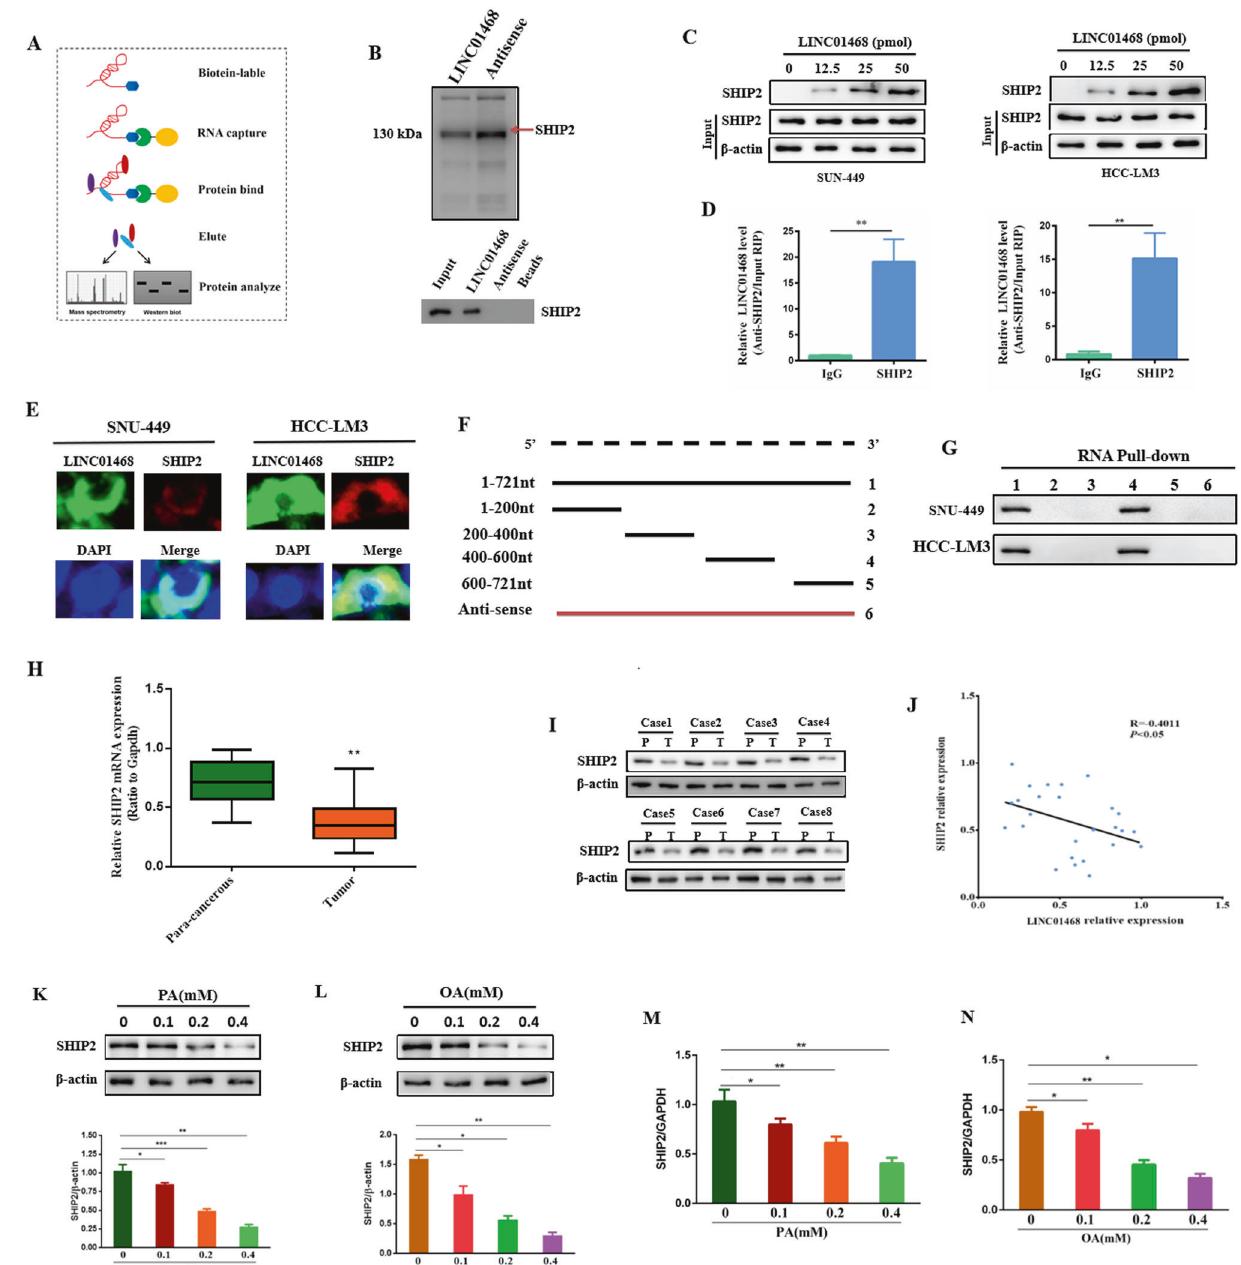
Fig. 4 LINC01468 directly binds with SHIP2. A RNA pull-down assay fl owchart was used to identify LINC01468-associated proteins. B The biotinylated LINC01468-associated proteins were stained with silver, and the bands speci fi cally precipitated by LINC01468 were excised and submitted for mass spectrometry (top) and western blot (bottom) analysis. The arrows indicate SHIP2 proteins as the unique bands for LINC01468. C The interaction of SHIP2 and LINC01468 was analyzed by western blot. D RIP assay was performed to detect LINC01468 enrichment in the immunoprecipitated complexes using anti-SHIP2 antibodies. E FISH and IF assays were performed to determine the co- localization of LINC01468 (Cy3; red) and SHIP2 (green) in cells. Nuclei, blue (DAPI). F Diagrams of full-length LINC01468 and its deletion fragments of the SHIP2-binding domain in LINC01468. G SHIP2 pulled down by different LINC01468 constructs was tested by western blot. H The expression analysis of SHIP2 from 26 pairs of HCC tissues and corresponding para-cancerous tissues from human NAFLD-HCC by qRT- PCR. I Western blot analysis of SHIP2 in human NAFLD-associated HCC. Representative western blot images and expression levels of tumors (T) and adjacent nontumors (NT) from eight paired NAFLD-associated HCCs. J Pearson correlation analysis of LINC01468 and SHIP2 expression in 26 HCC tissues. K , L SHIP2 protein expression in palmitic acid- ( K ) or oleic acid-treated ( L ) SNU-182 cells ( n = 3 per group). ** P < 0.01. M , N LINC01468 expression in ( M ) palmitic acid- or ( N ) oleic acid-treated SNU-182 cells by qRT-PCR ( n = 3 per group). The data represent the mean ± S.D (* P < 0.05; ** P < 0.01; *** P < 0.005).